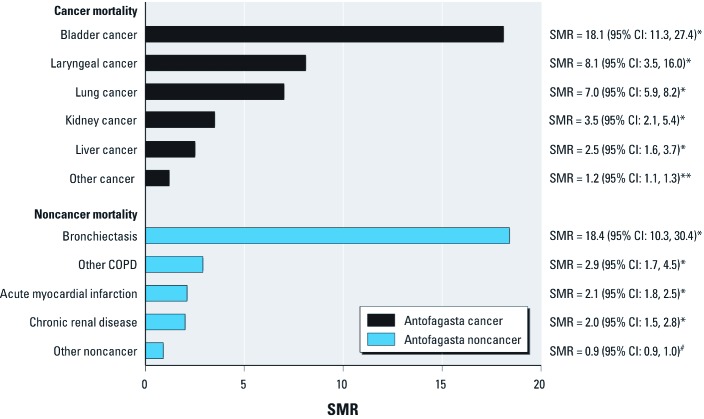
Summary of SMRs for 30–49-year-old males and females (pooled) who were born in Antofagasta, Chile, combining those born before and during the high-exposure period (Smith et al. 2006; Yuan et al. 2007, 2010). *p ≤ 0.001. **p = 0.002. #p = 0.93.